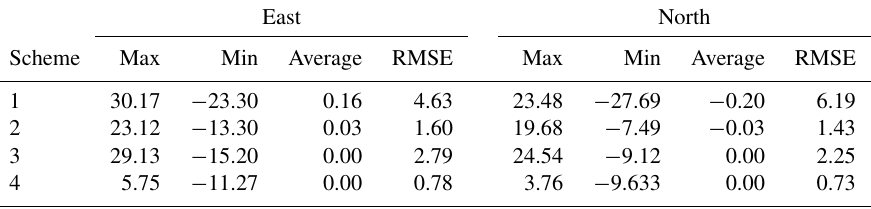
Table 5. Velocity residuals statistics (mmyr − 1